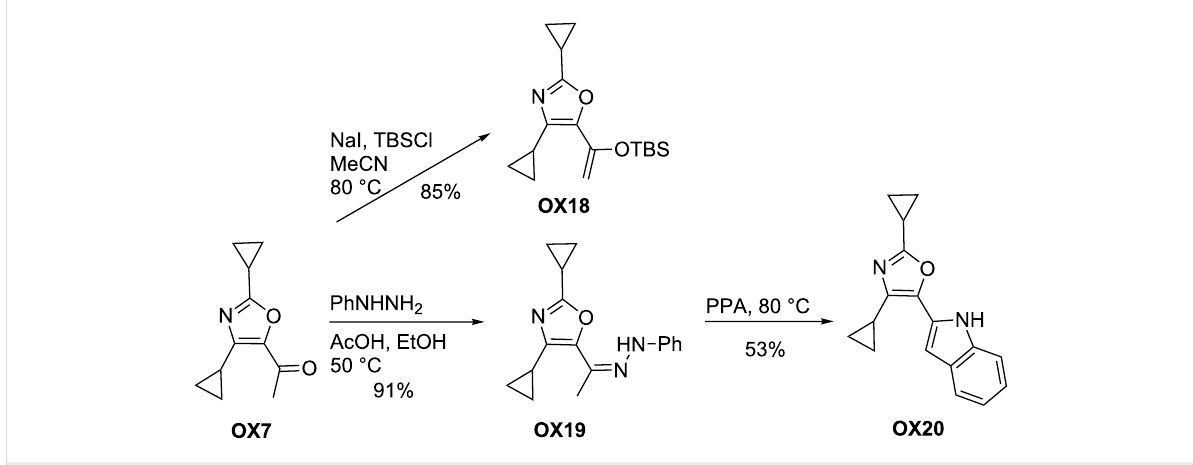
Scheme 26: Conversions of 2,4-dicyclopropyl-substituted oxazole OX7 into oxazole derivatives OX18 – 20 (PPA = polyphosphoric